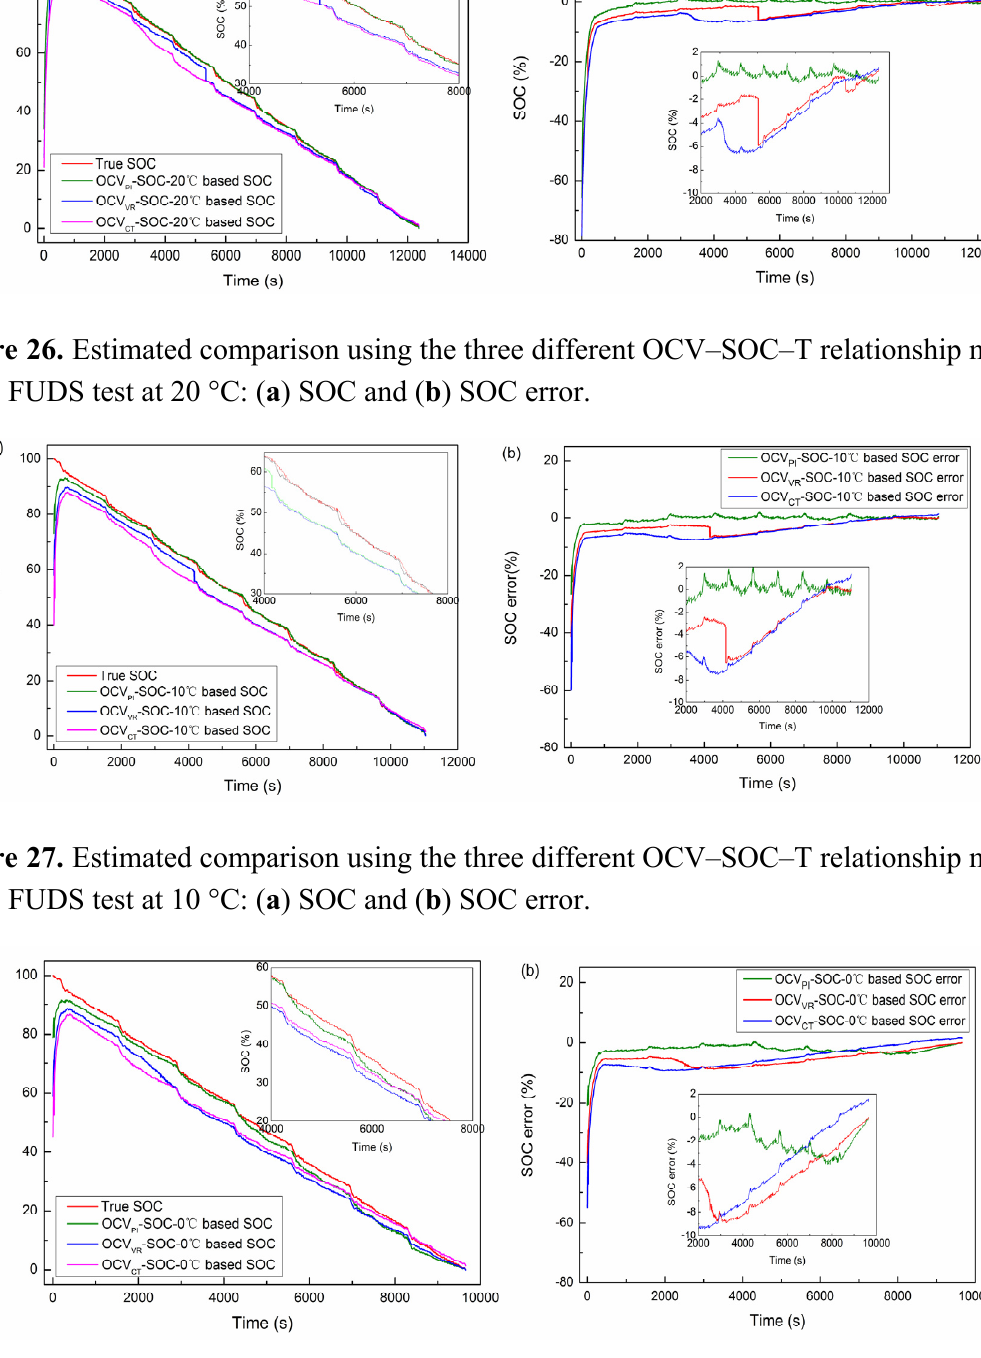
Figure 28. Estimated comparison using the three different OCV–SOC–T relationship maps in the FUDS test at 0 °C: ( a ) SOC and ( b ) SOC